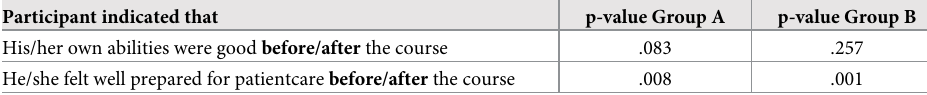
Table 2. Illustration of differences within a group. Participant indicated that p-value Group A p-value Group